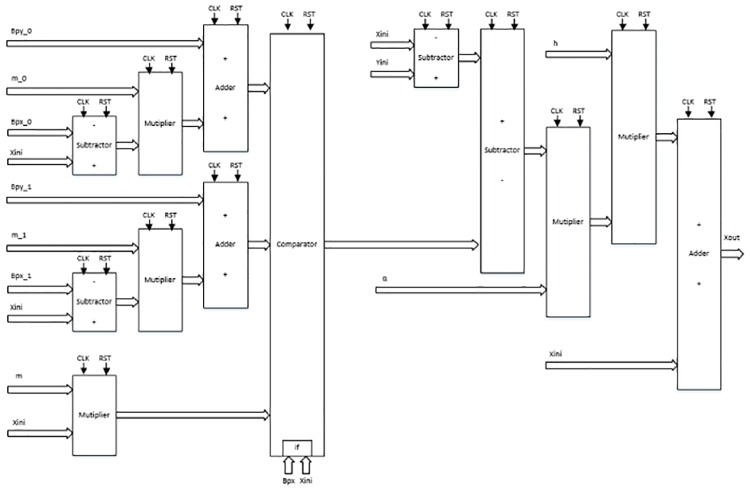
Hardware connection for implementing x[k + 1] from Eq (11).